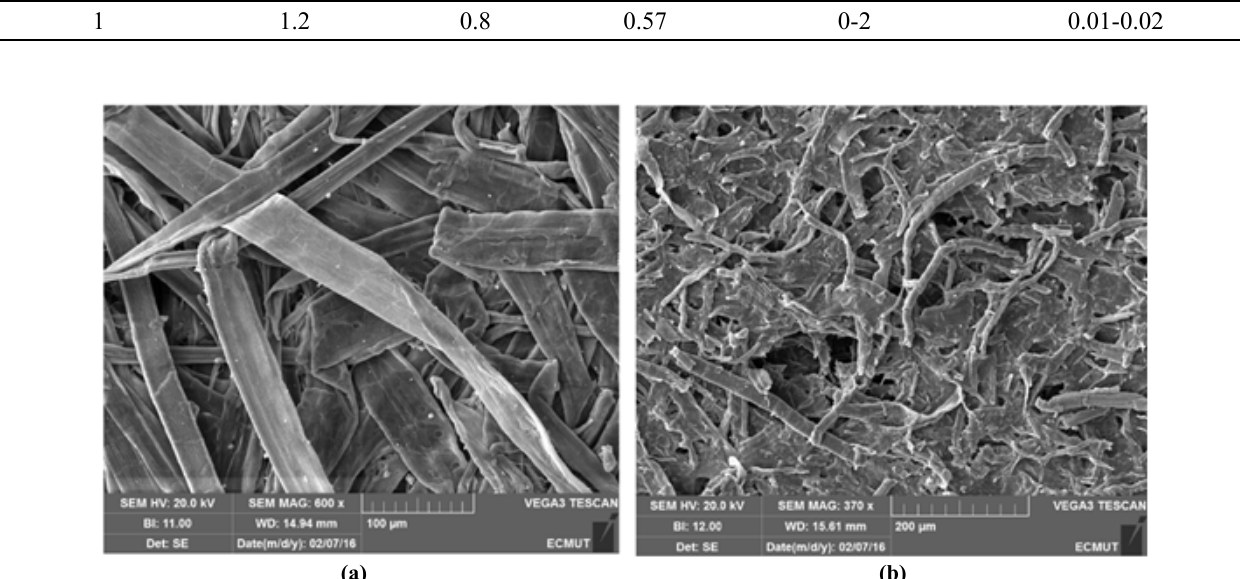
Fig.2. SEM images of (a) Kraft and (b) cellulose microfibers